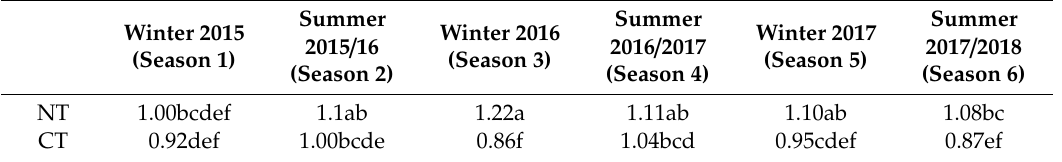
Table 4. Interactive e ff ects of season and tillage on soil organic carbon (%) at the 0–5 cm depth in a maize-based conservation agriculture system in a semiarid climate in South Africa.